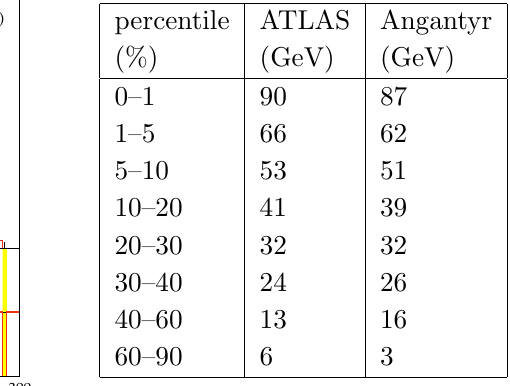
4 : 9 < (cid:17) < 3 : 2) for pPb (cid:0) (cid:0)